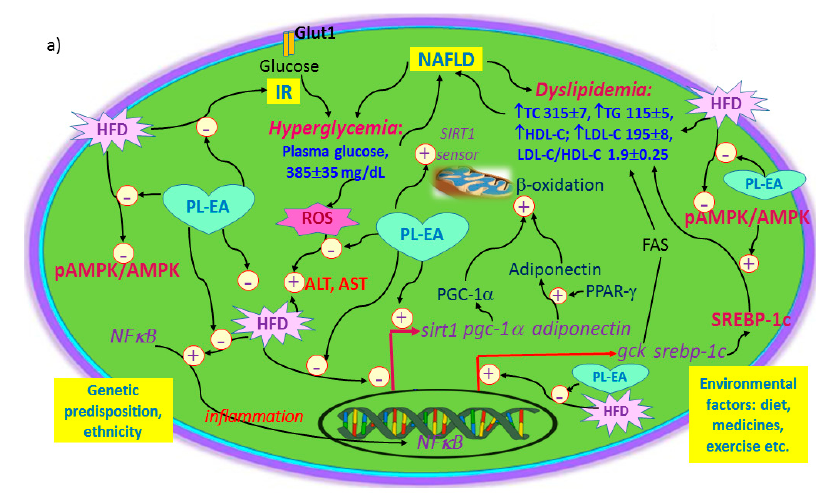
Figure 11. Effects of ethyl acetate fraction from P. linteus mycelia on the relative proteins expression of mice livers. Representative Western blots (left panel) and quantified bar graphs relative to each control (right panel) showing alterations among groups. HFD: high-fat/high-fructose diet (HFD). PL-EA-L: HDF + low dose PL-EA (35 mg/kg). PL-EA-H: HDF + high dose PL-EA (70 mg/kg). Data are expressed as mean ± SE ( n = 9). # p < 0.05; ## p < 0.01; ### p < 0.001 vs. the HFD group; * p < 0.05; ** p < 0.01; *** p < 0.001 vs. control. PPAR γ : peroxisome proliferator-activated receptor gamma. AMPK: AMP activated protein kinase. p -AMPK: phosphorylated AMPK. PGC1- α :